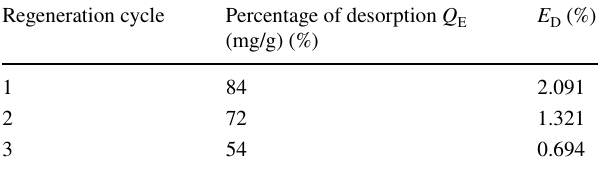
Table 5 Column regeneration parameters for NBP